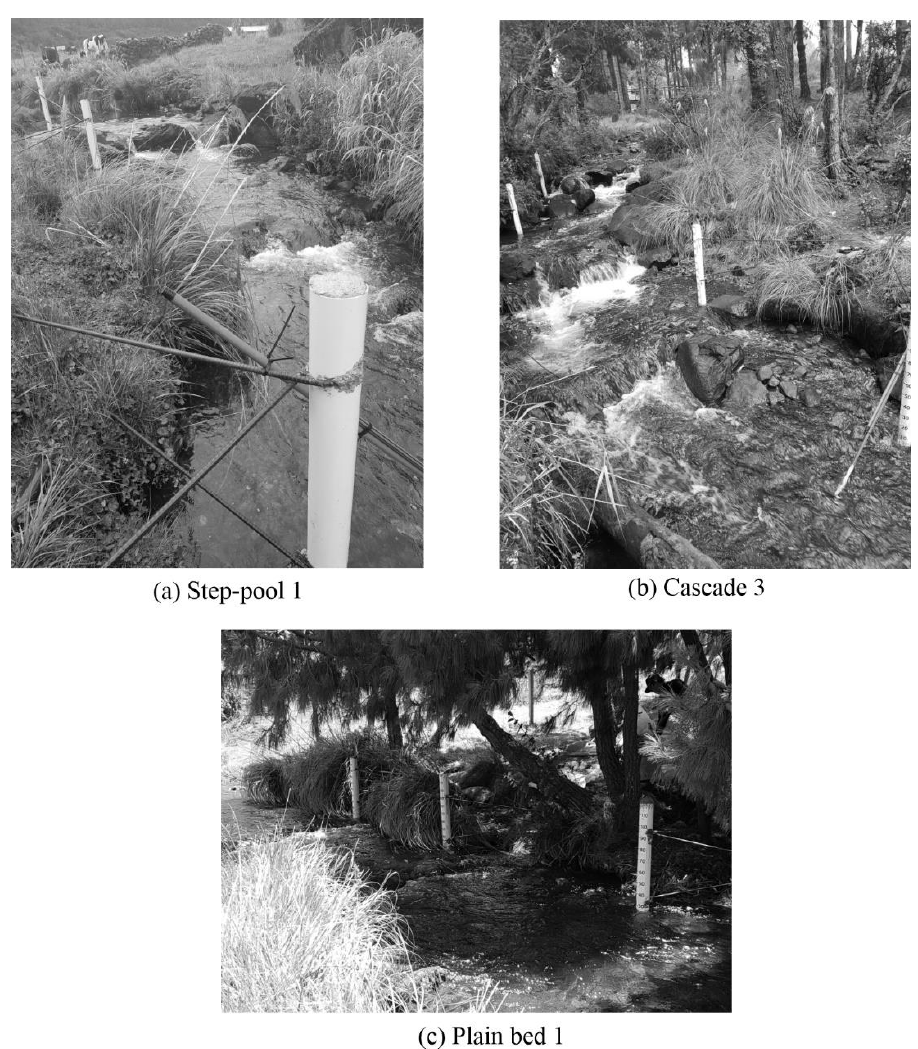
Figure 3. Pictures of analyzed reaches. ( a ) Step-pool 1 ( b ) Cascade 3 ( c ) Plain bed 1.